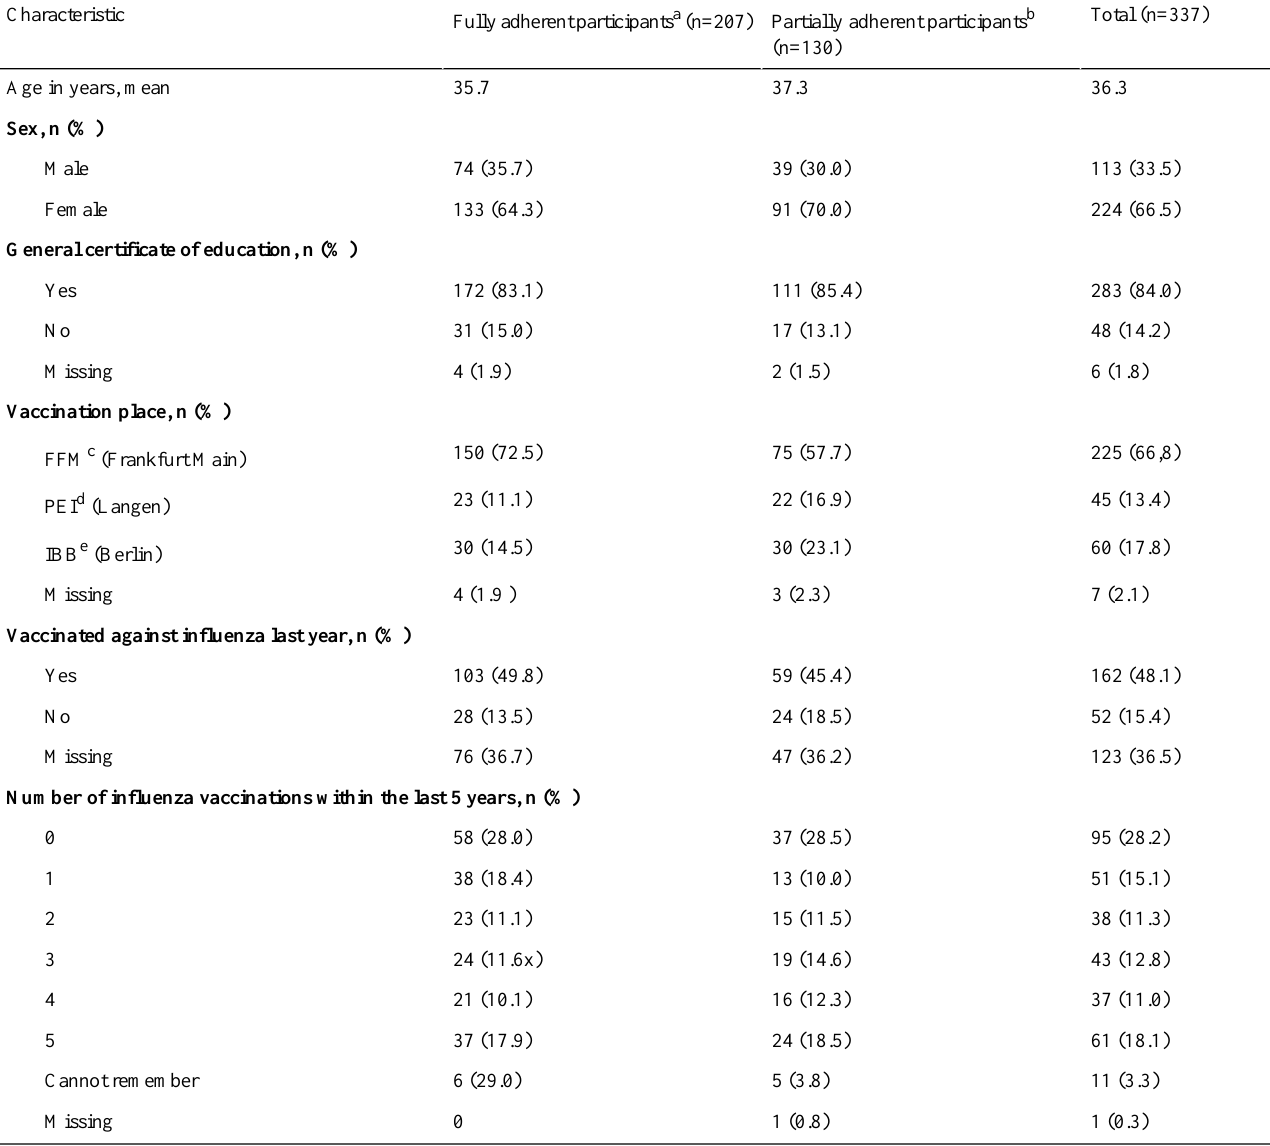
Table 1. Characteristics of study participants according to adherence to app